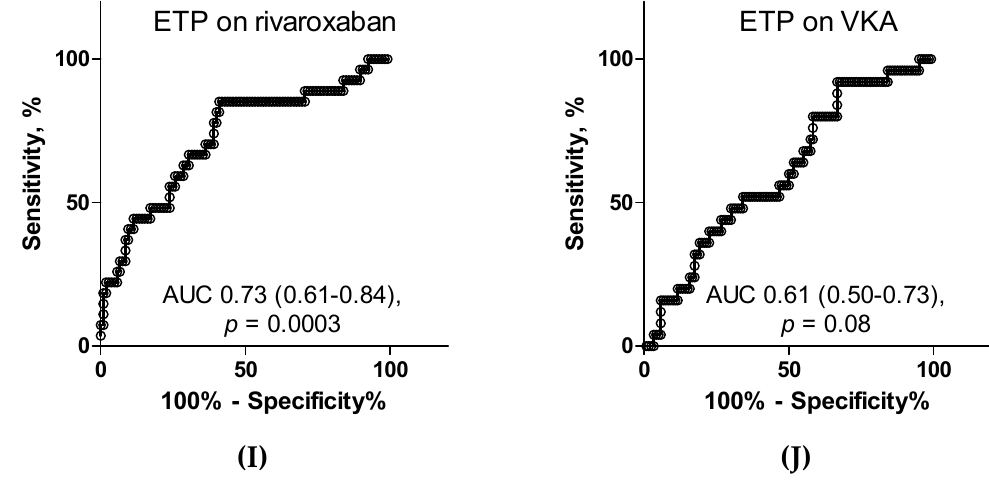
Figure 3. The receiver operating characteristics curves for calibrated automated thrombography parameters in prediction of minor bleedings. In patients on rivaroxaban, the highest predictive value for minor bleedings had lag time ( A ), TTP ( C ), max IIa ( E ) and max rate ( G ) and moderate ETP ( I ). In patients on VKA, moderate predictive values reached max IIa ( F ) and max rate ( H ) whereas lag time (B), TTP (D) and ETP (J) had no predictive value. Abbreviations: AUC: area under the curve, VKA: